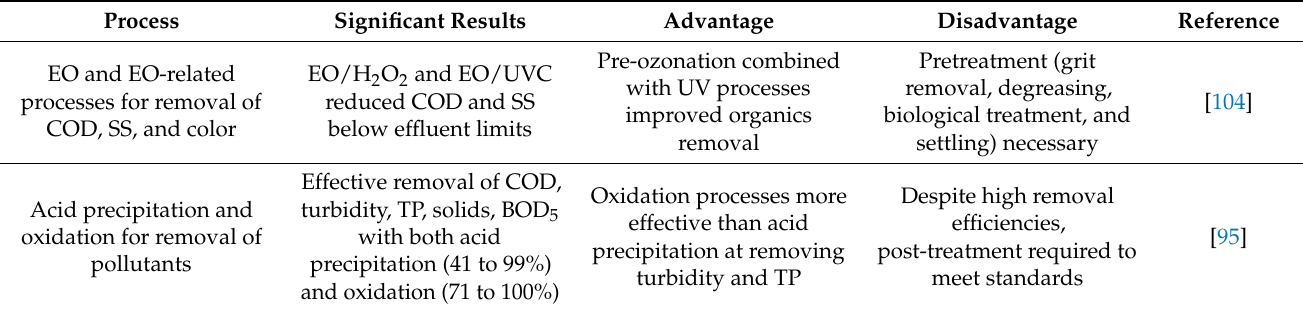
Table 4. Chemical/Physiochemical treatment methods for SWW. Abbreviations for common terms in table